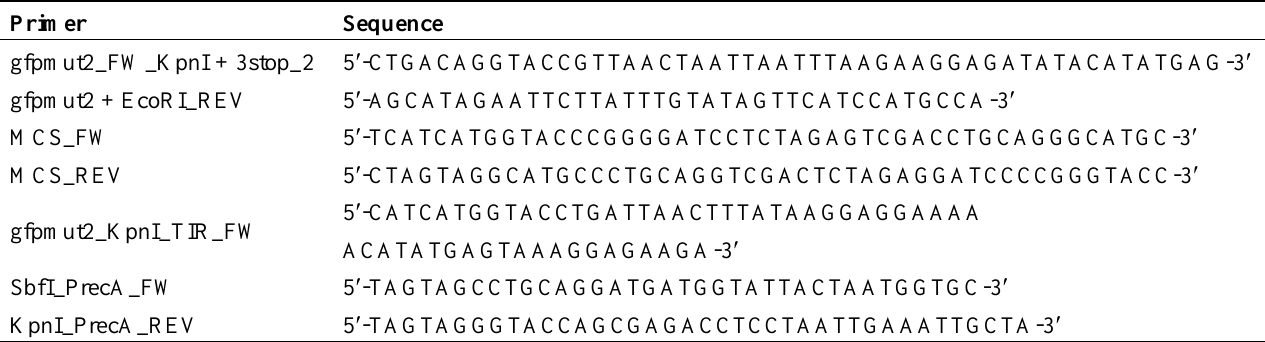
Table 2. Primers used in plasmid